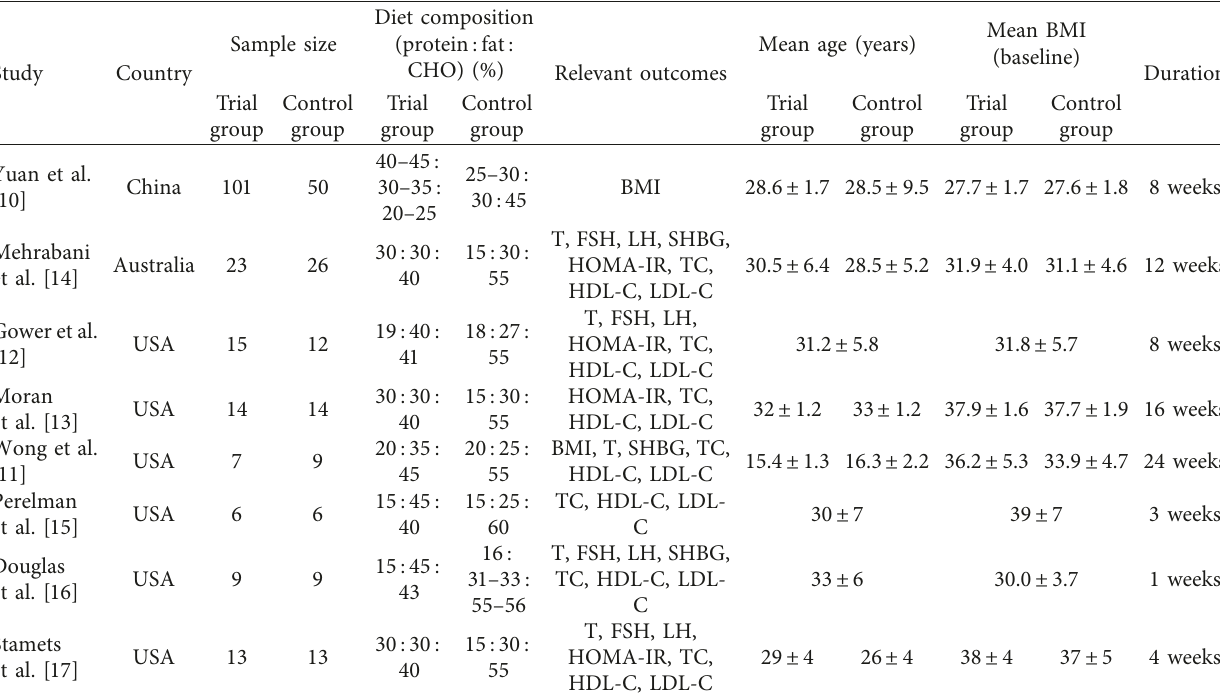
Figure 1: Flowchart of literature search, review process, and selection of studies. Table 2: Characteristics of the included